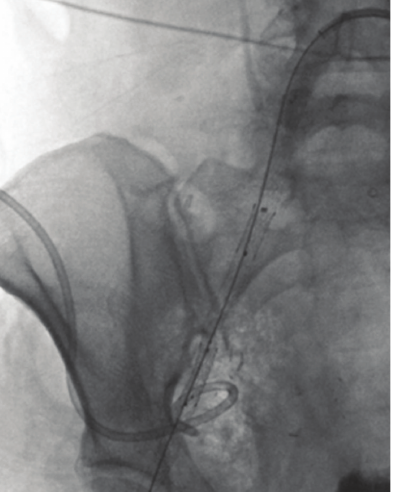
Figure 4: Fluoroscopic spot image demonstrates covered stents deployed across right common and external iliac